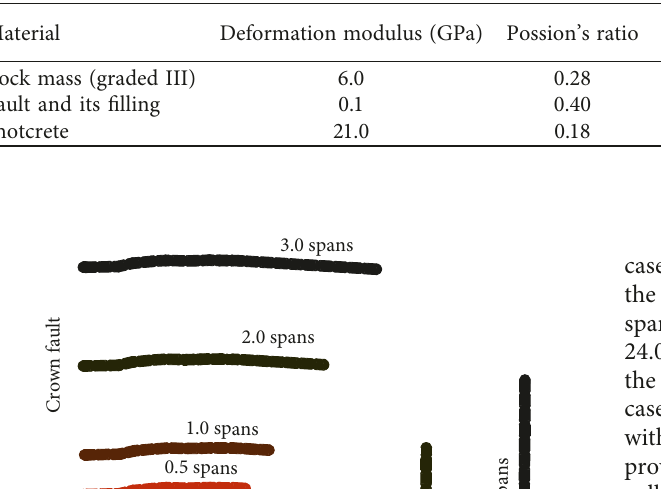
Table 1: Mechanical parameter for rock mass and mining tunnel supporting material.